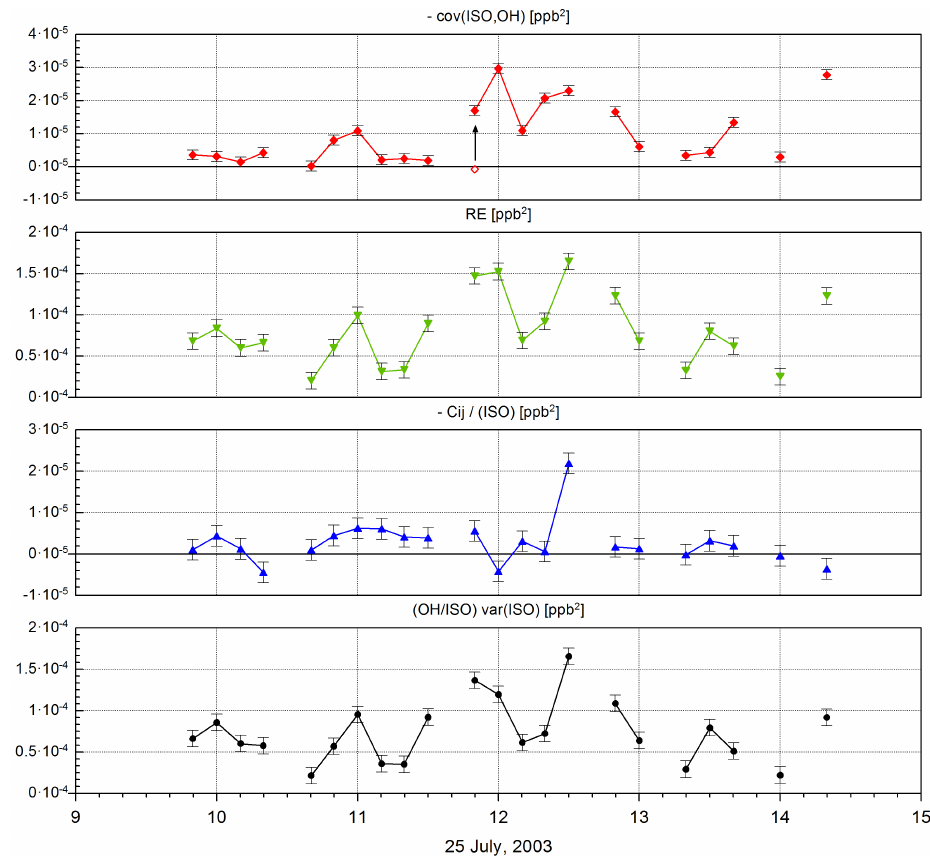
Figure 15. The four terms of Eq. (15) solved for RE as a function of time.